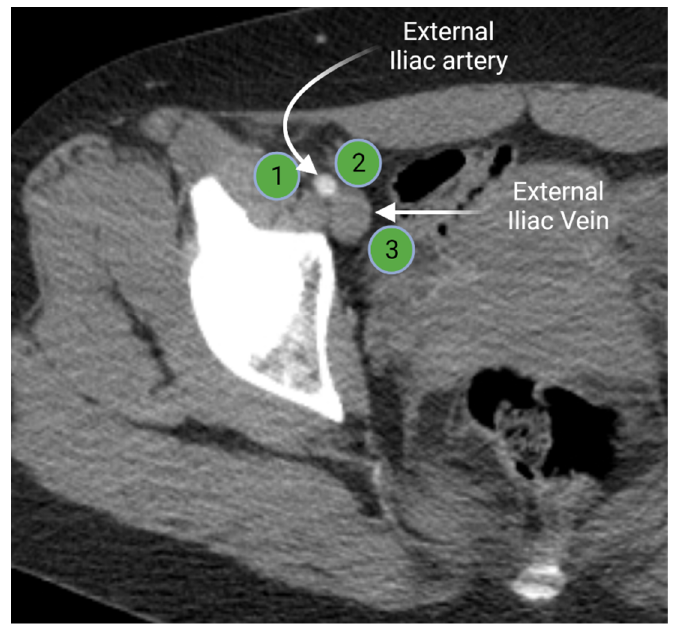
Figure 3. Axial contrast-enhanced computed tomography of the right hemipelvis demonstrates the right external iliac artery and veins with associated lateral ( 1 ), middle ( 2 ), and medial ( 3 ) external iliac lymph nodes. “Created by BioRander.com. accessed on 10 August 2021”. The internal iliac lymph nodes drain the pelvic organs and follow the branches of the internal iliac artery. These lymph nodes are sometimes referred to as the hypogastric lymph nodes, which are located posteriorly in the pelvis. The internal iliac lymph chain includes multiple lymph node groups. Most identified internal iliac lymph node groups include the anterior iliac, lateral sacral, and presacral lymph nodes. The anterior internal iliac lymph nodes run along the anterior division of the internal iliac artery (Figure 4). The presacral lymph nodes are in the midline anterior to the sacrum. The lateral sacral lymph nodes follow the lateral sacral artery (Figure 4) [15,16].